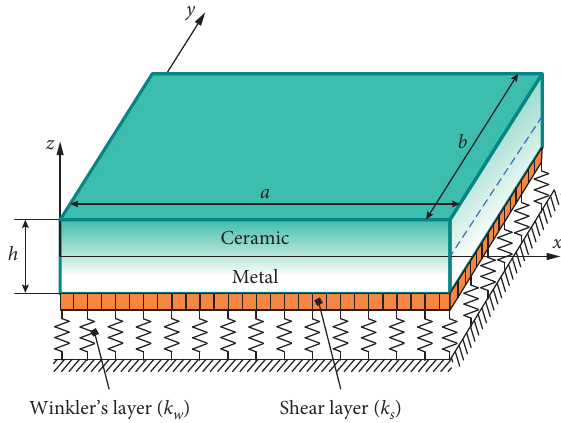
Figure 1: The model of FGM plates resting on Winkler–Pasternak